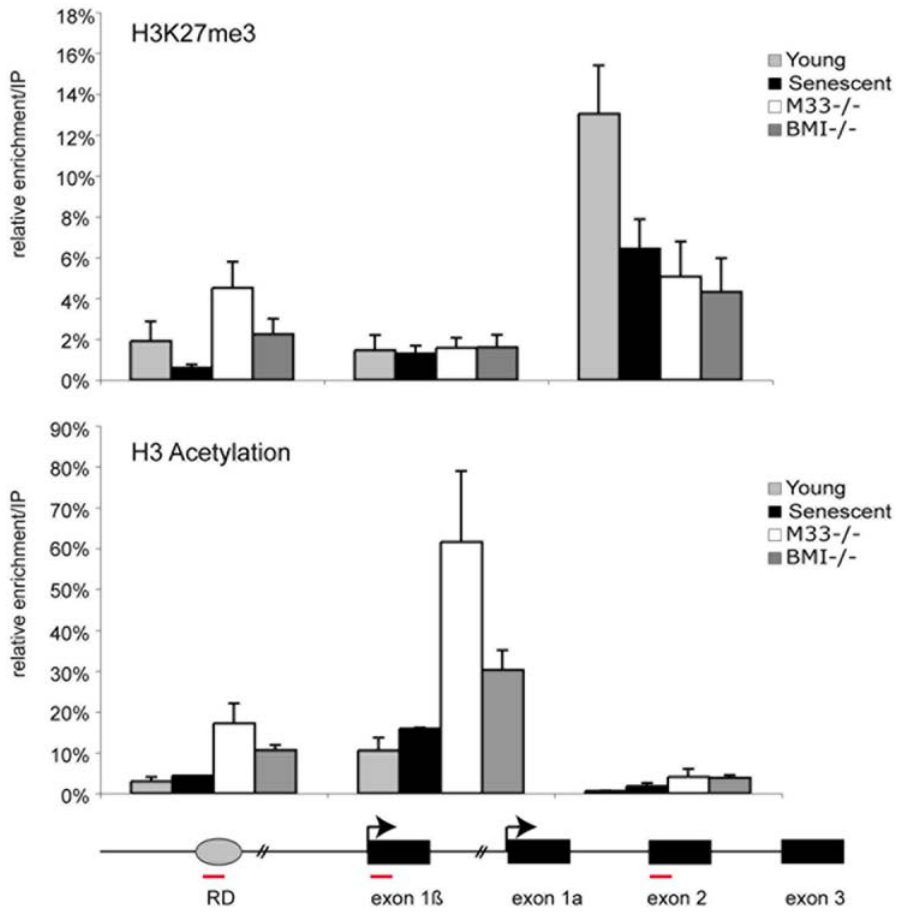
Figure 2. Loss of EZH2 binding and H3K27me3 methylation at the INK4a/ARF locus during senescence. P3 proliferating and P10–12 senescent MEFs were subjected to ChIP assays using the indicated antibodies.